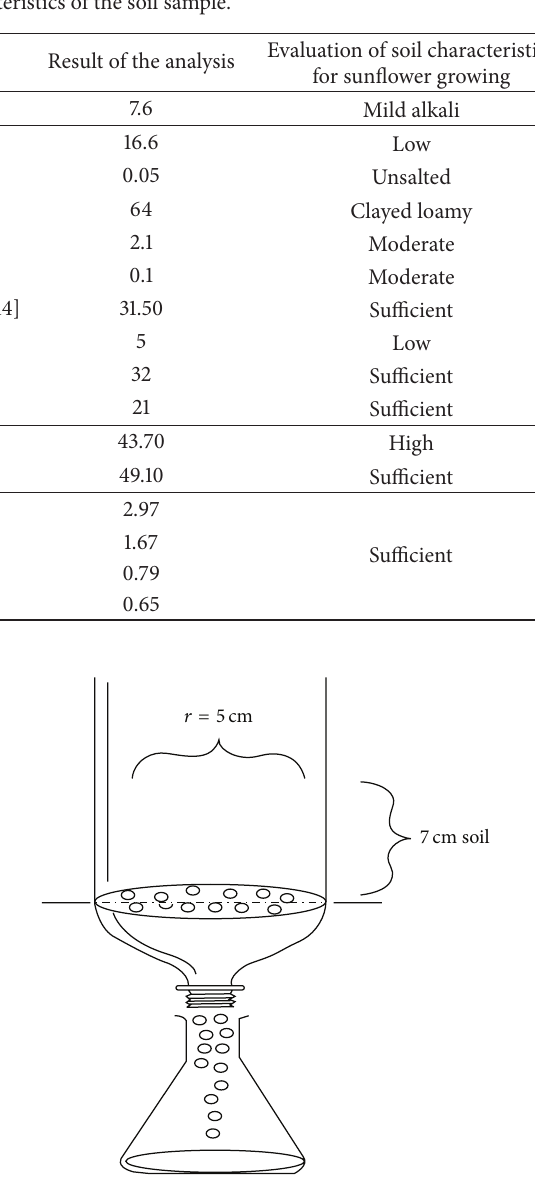
Table 1: Physical and chemical characteristics of the soil sample.